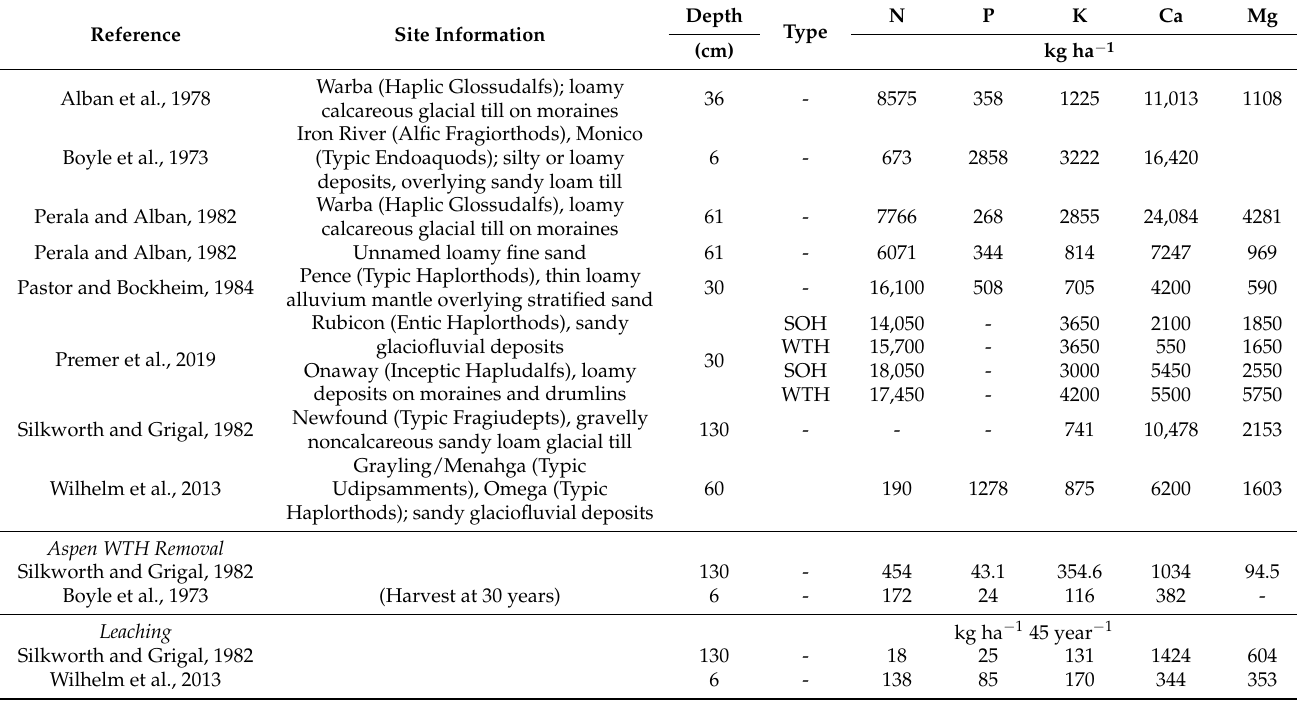
Table A3. Literature values of ecosystem nutrients in the Great Lakes region extrapolated from the sampling depth to 150